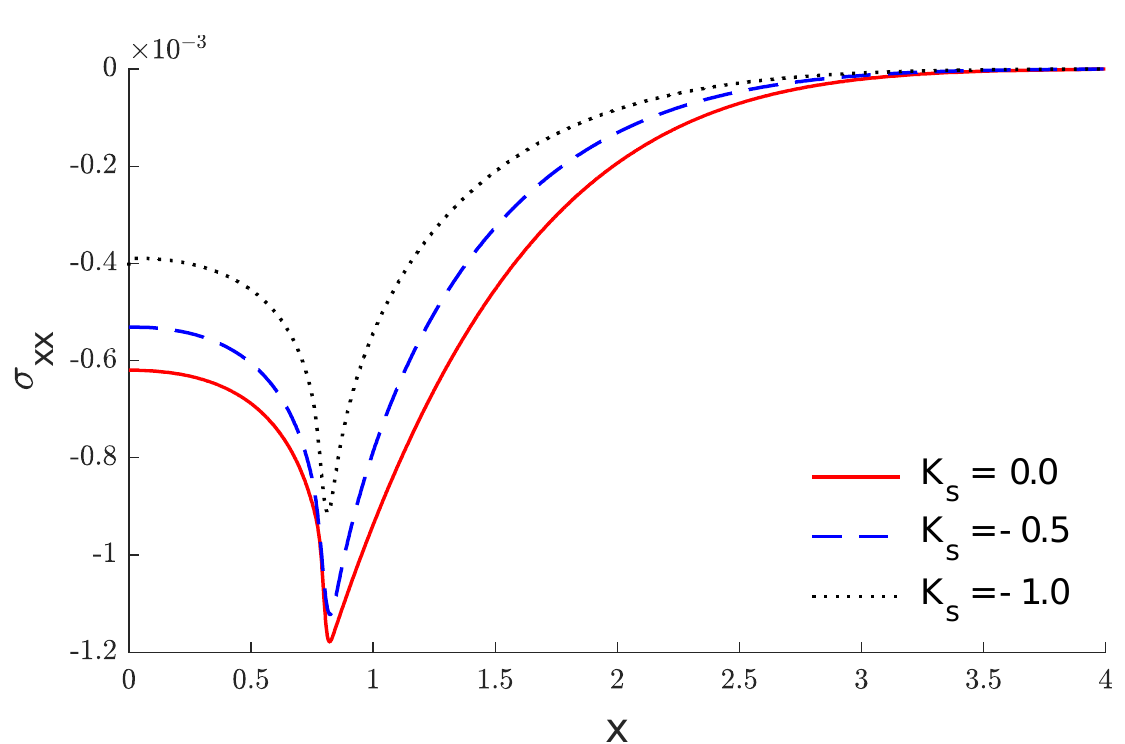
Figure 3. The carrier density variations under various values of 𝐾 𝑠 .